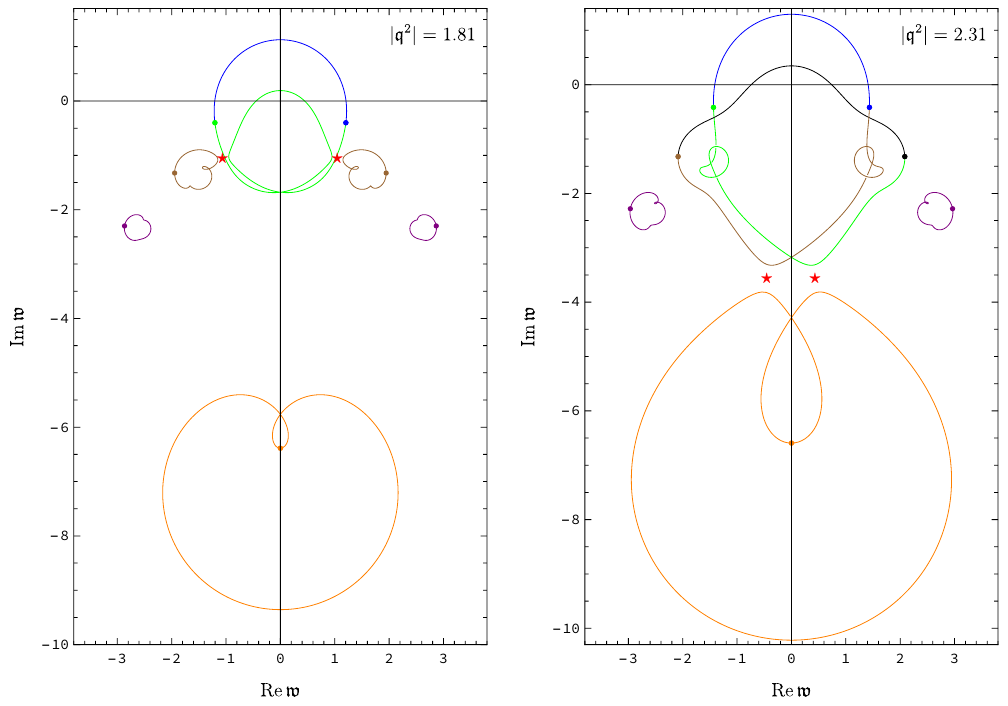
Figure 14 . Quasinormal spectrum in the sound channel of Gauss-Bonnet theory, computed non- perturbatively in λ , at λ = − 0 . 02 . The trajectories are plotted for complex values of the GB GB spatial momentum squared, q 2 = | q 2 | e iϕ , where phase ϕ is varied from 0 to 2 π . The positions of quasinormal modes at ϕ = 0 are shown by dots. The positions of the critical points are shown by red